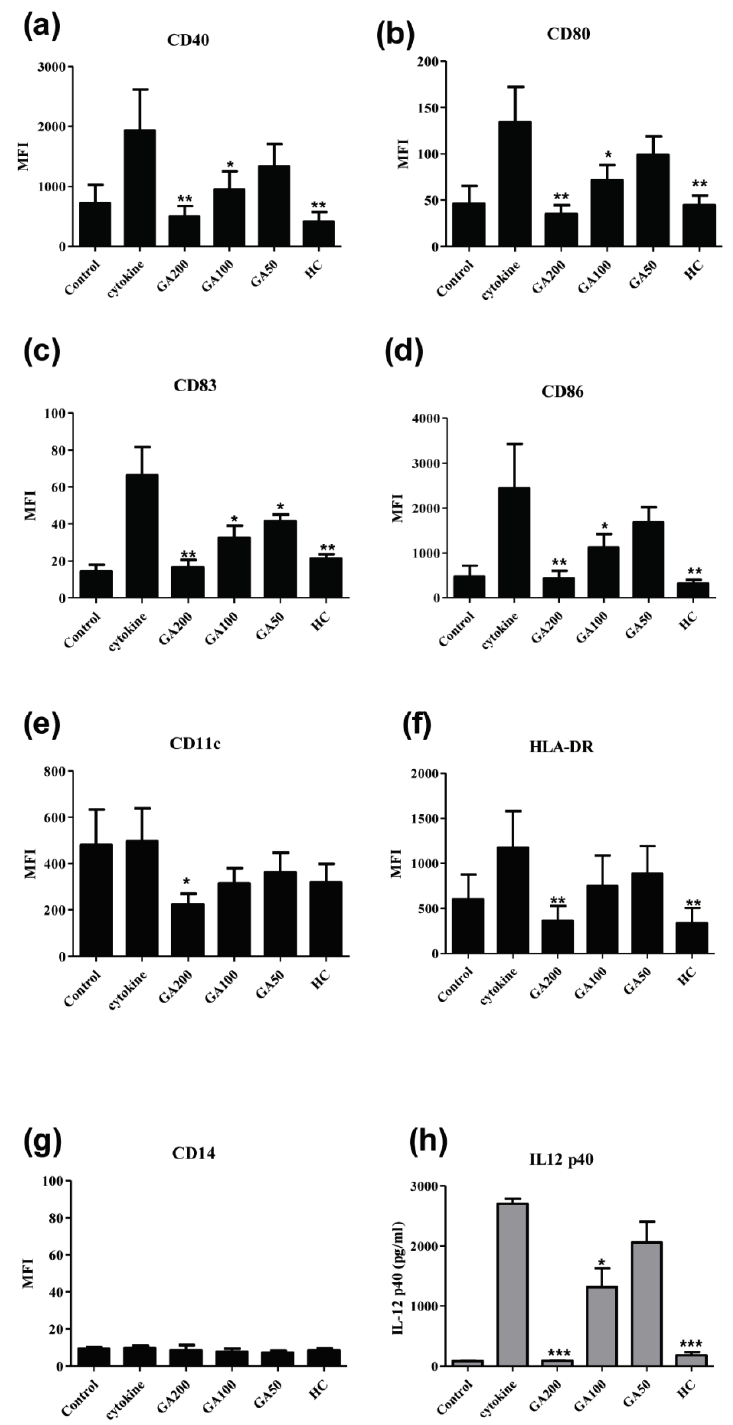
Figure 4. Effects of gallic acid on the surface expression of the functional markers on human monocyte-derived dendritic cells (moDC) ( n = 4) Control (cells without adding DC-inducing cytokine cocktail); GA200: gallic acid (200 μ g/mL); GA100: gallic acid (100 μ g/mL); GA50: gallic acid (50 μ g/mL); HC: hydrocortisone (2 μ M). * , ** and *** indicate p < 0.05; p < 0.01 and p < 0.001, respectively, when compared the level of the cytokine production or surface marker expression from cells without incubated with DC-inducing cytokine cocktail (control). ( a ) CD40; ( b ) CD80; ( c ) CD83; ( d ) CD86; ( e ) CD11c; ( f ) HLA-DR; ( g ) CD14 and ( h ) IL12